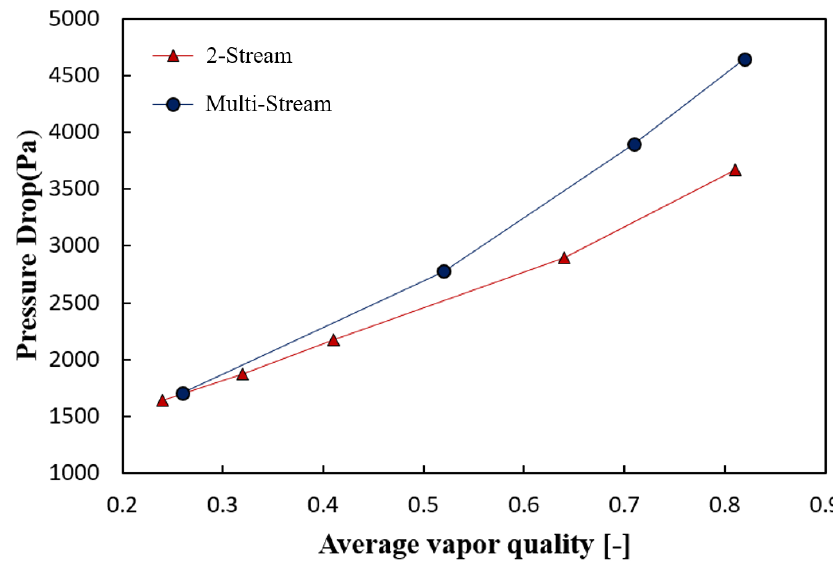
Figure 13. Difference of pressure drop between multi-stream and 2-stream heat transfer.